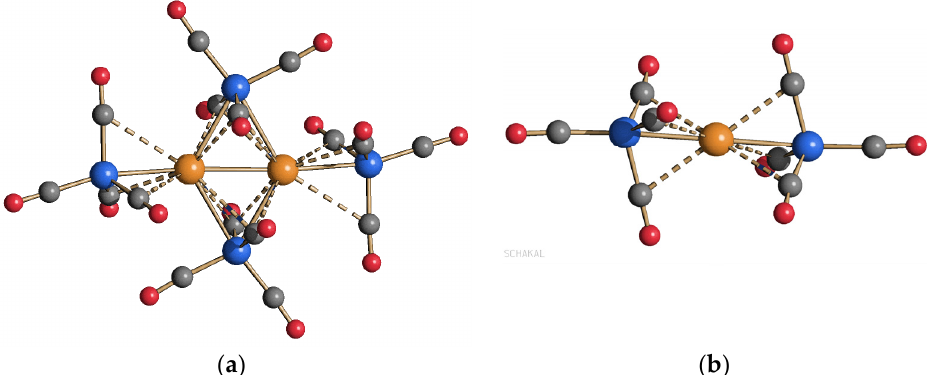
Figure 6. Molecular structure of ( a ) the dimer [Ag 2 {Co(CO) 4 } 4 ] 2 − ( 5 ) compared to ( b ) the monomer 3 . Sub Van der Waals Ag ··· C(O) contacts are represented as fragmented lines (orange, Ag; blue, Co; red, O; grey, C).